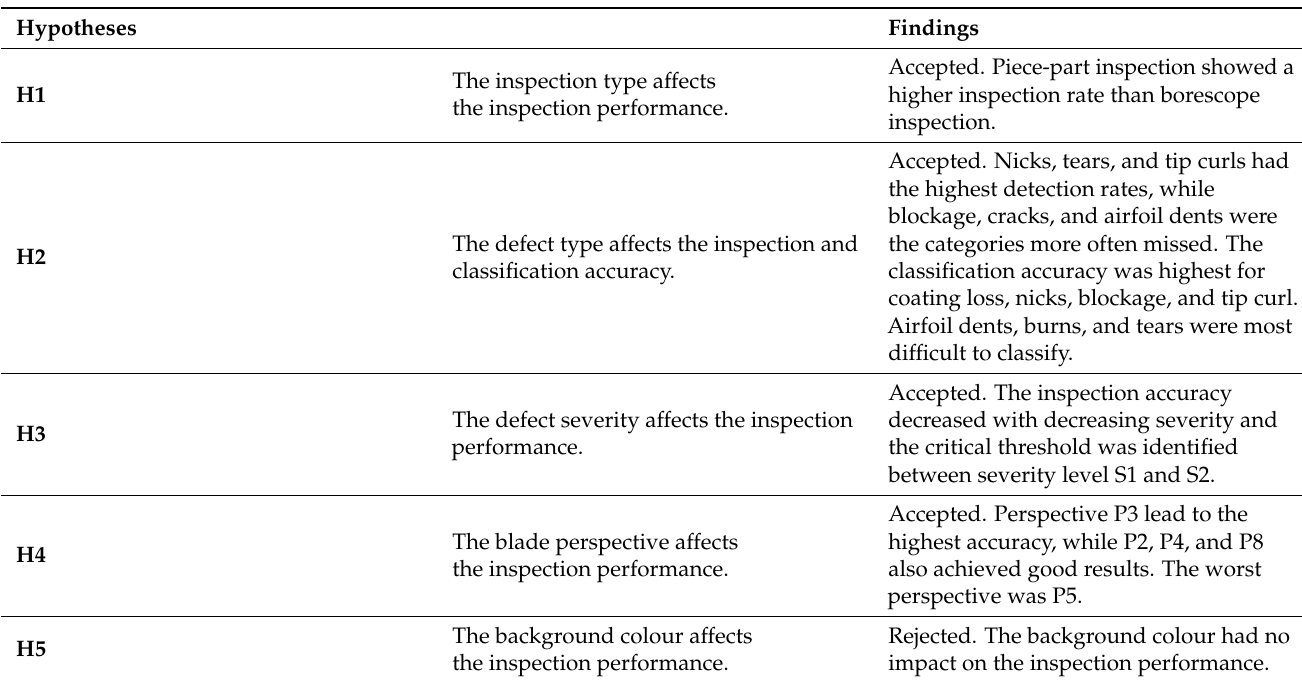
Table 8. Research hypotheses and